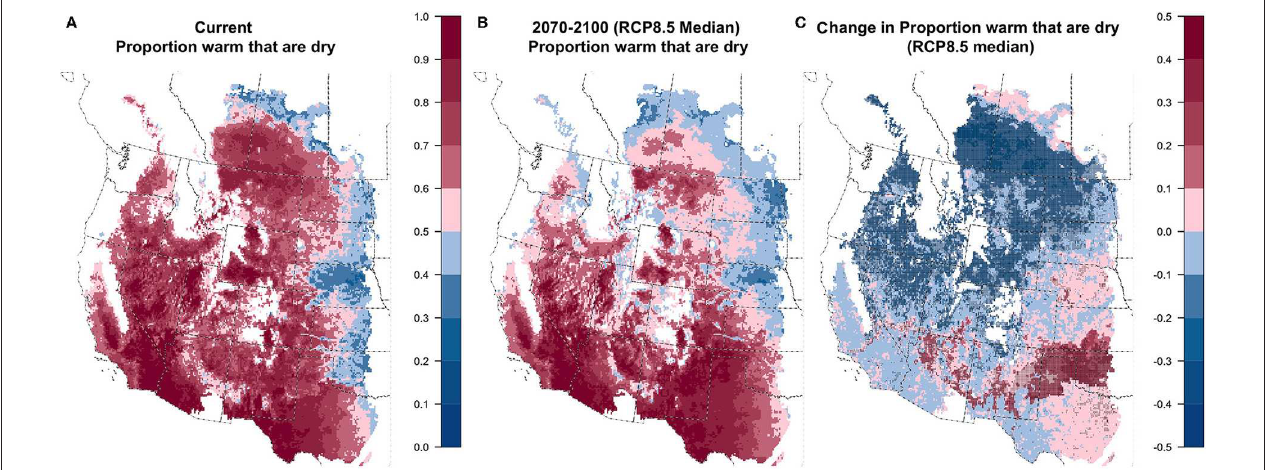
FIGURE 5 | Current (A) , future ( B ; 2070–2100; RCP8.5 median model), and change (C) in DRY PROP : proportion of days with all soil layers dry when T 50 > 5 ◦ C.